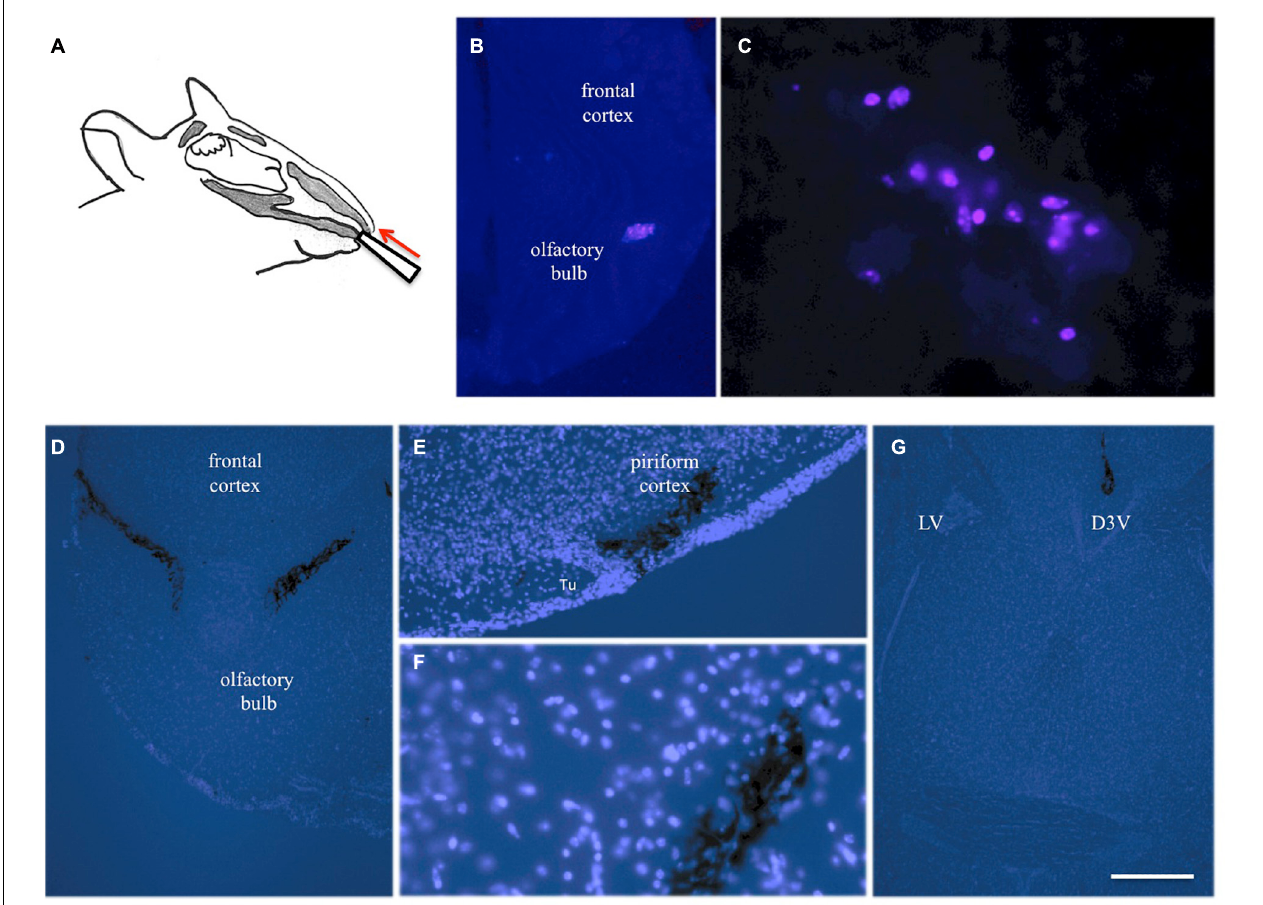
FIGURE 3 | Intranasal infusion into mice. Substances (10 µ l) were infused via the left and right nostril in anesthetized mice using a 10 µ l pipette (A) . Twenty four hours after infusion of blue fluorescent labeled beta-amyloid several blue-labeled cells were seen in the bulbus, indicating phagocytosis of the peptide (B,C) . Three hours after infusion of cresyl violet several labeled areas were seen in the bulbus (D) , piriform cortex (E,F) and hippocampus (G) . Brains were counterstained with blue DAPI and pictures are merged with bright-light black labeled cresyl violet. Scale bar in (G) = 150 µ m (B,D,G) and 75 µ m (C,E,F) . D3V, 3rd ventricle; LV lateral ventricle; Tu, olfactory